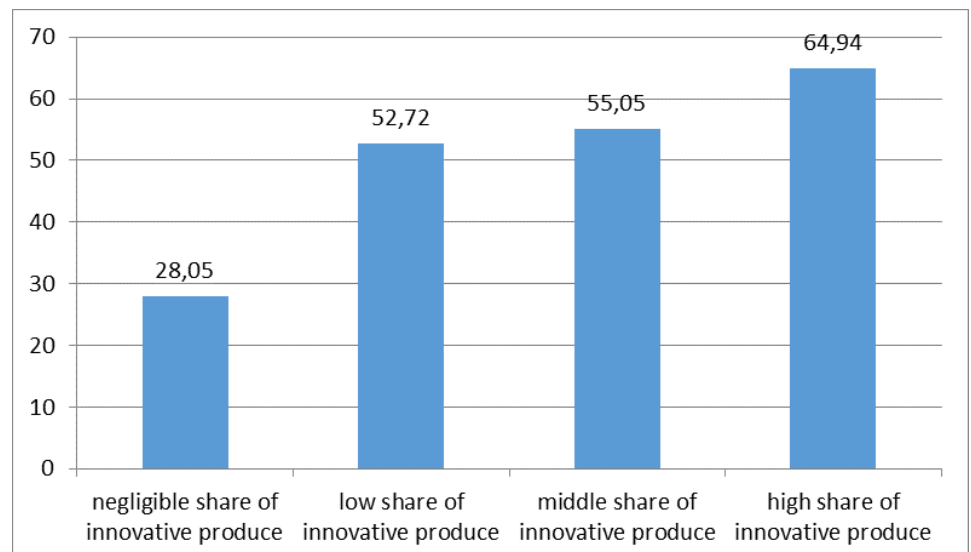
Figure 11: Average values of share of companies implementing EE-innovations by group of regions with differing share of innovative produce in overall